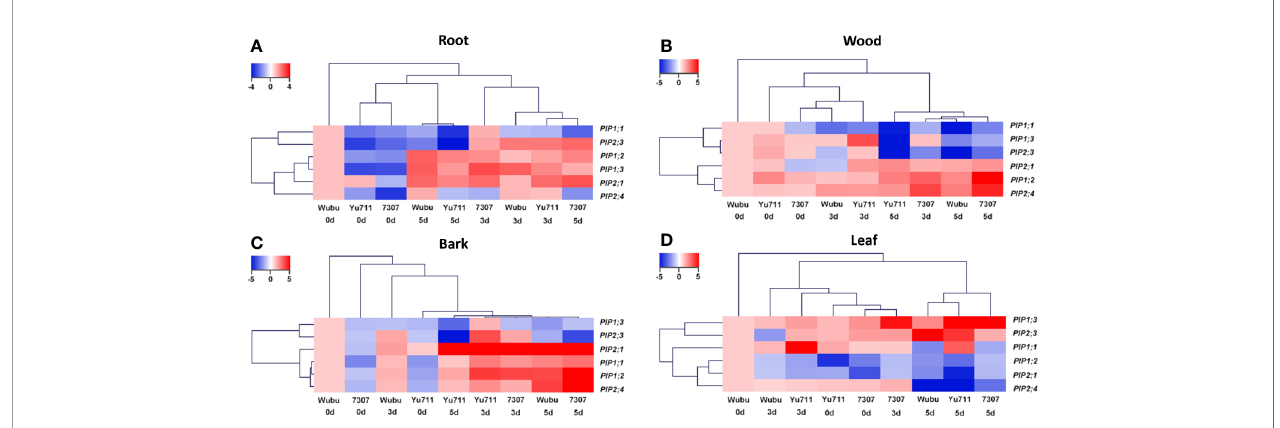
FIGURE 2 | Fold changes of transcript levels of PIPs in roots (A) , wood (B) , bark (C) and leaves (D) of mulberry cultivar Wubu, Yu711, and 7307 exposed to progressive drought stress for 0, 2, and 5 days (denoted as 0 d, 2 d, and 5 d), respectively. Fold changes of transcript levels of PIPs in roots, wood, bark or leaves of Wubu at day 0 were de fi ned to be 1.